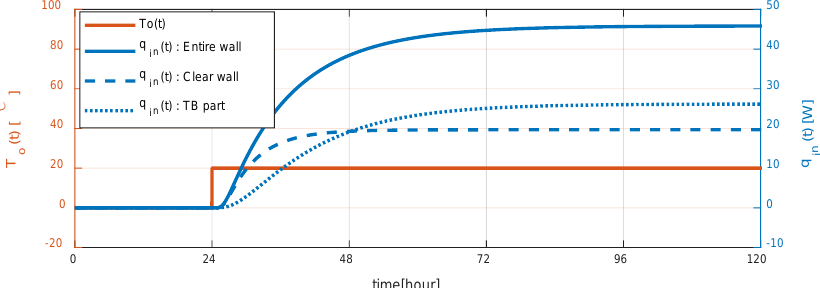
is the outdoor 𝑇𝑇 𝑜𝑜